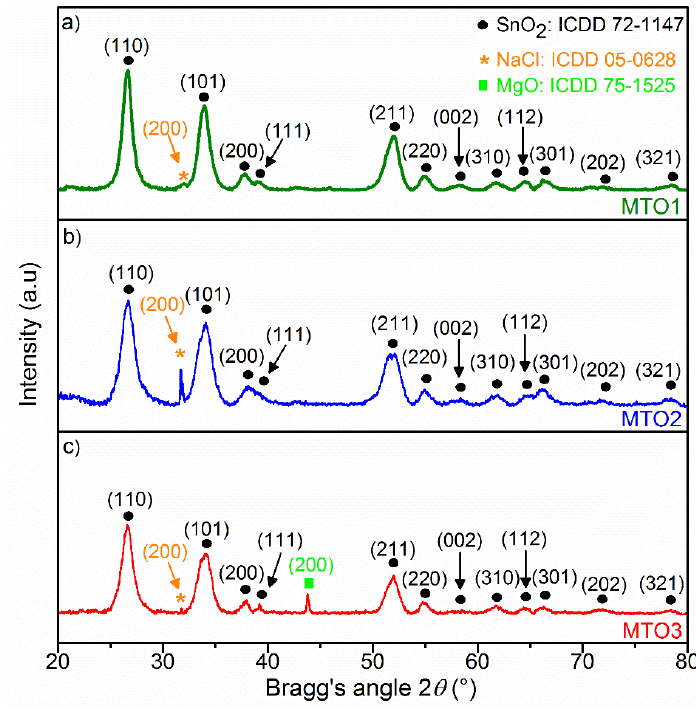
Figure 2. XRD patterns of the Mg-doped SnO 2 thin films, ( a ) 0.8 at.% magnesium-doped tin dioxide (MTO1); ( b ) 1.2 at.% magnesium-doped tin dioxide (MTO2); ( c ) 1.6 at.% magnesium-doped tin dioxide (MTO3). Table 1. Lattice parameters and average crystalline size of the Mg-doped SnO 2 thin films.